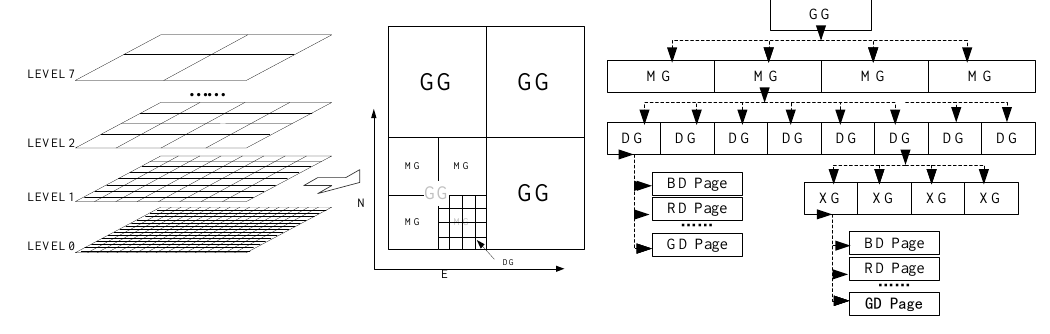
Figure 1. Illustration of the Multi-Scale Grid index.